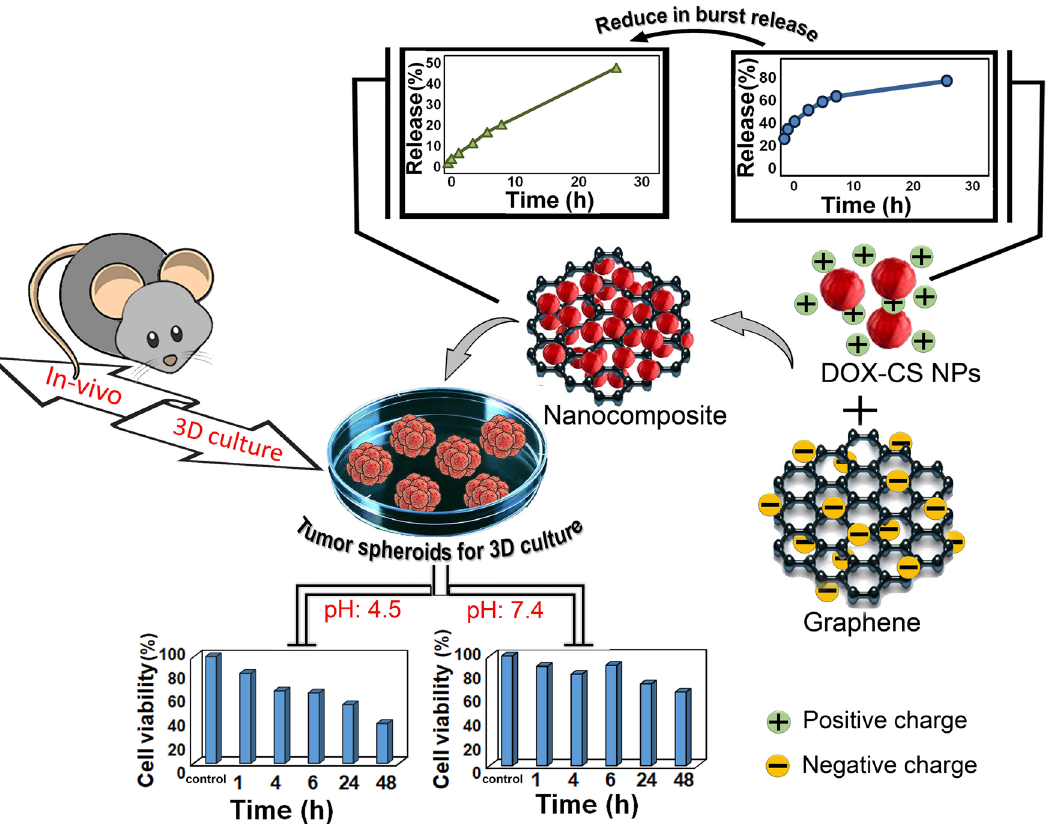
Figure 1. Schematic representation of the fabrication process of BSG/chitosan nanocomposites and comparison of release with chitosan nanoparticles and study of 3D